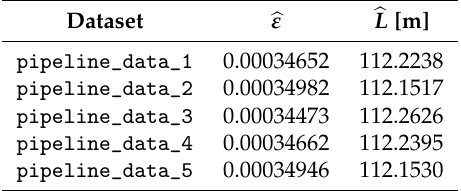
Table 2. Roughness and length estimates from different